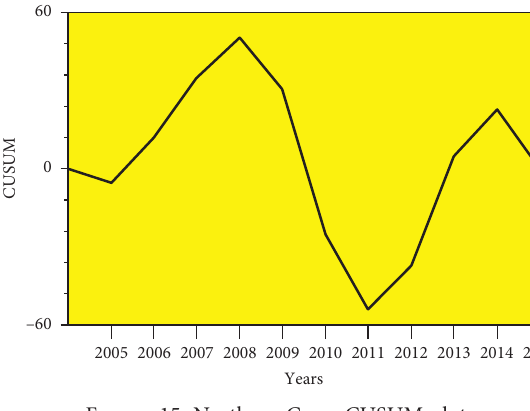
Figure 15: Northern Cape: CUSUM plot.